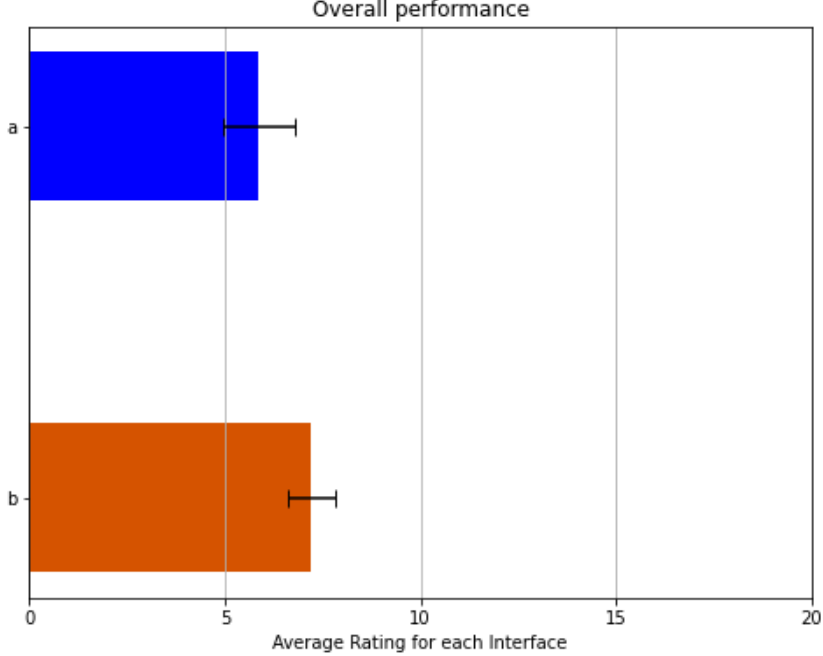
Figure 14. Overall performance of the reduced contractions subset version. ( a ) is the score from the able-bodied subjects; and ( b ) is the one with volunteers with upper-limb